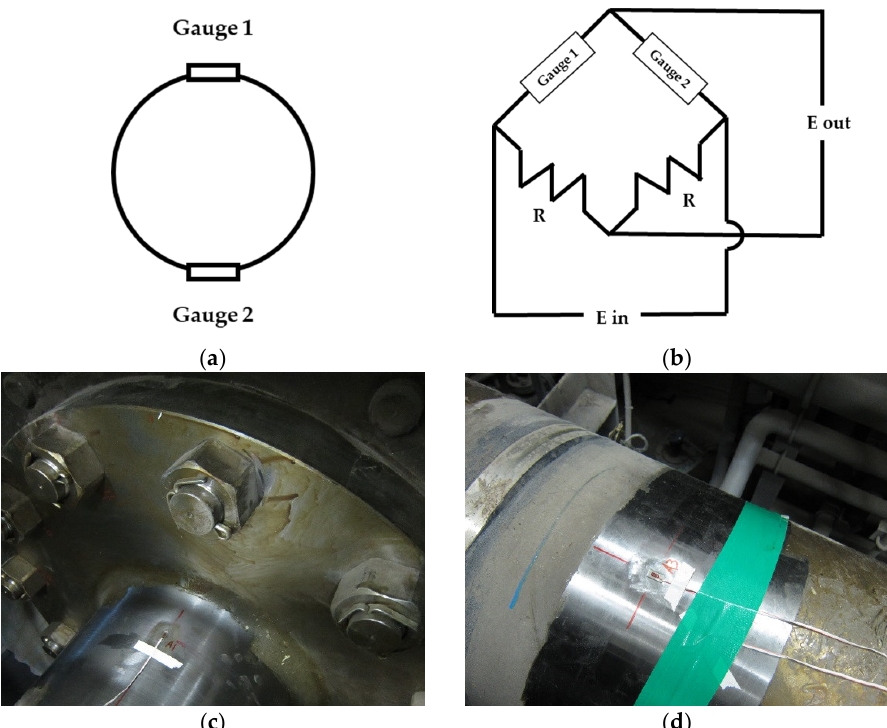
Figure 4. ( a ) Wheatstone bridge connection method, ( b ) strain gauge attachment locations, and ( c ) and ( d ) strain gauge attachment examples.